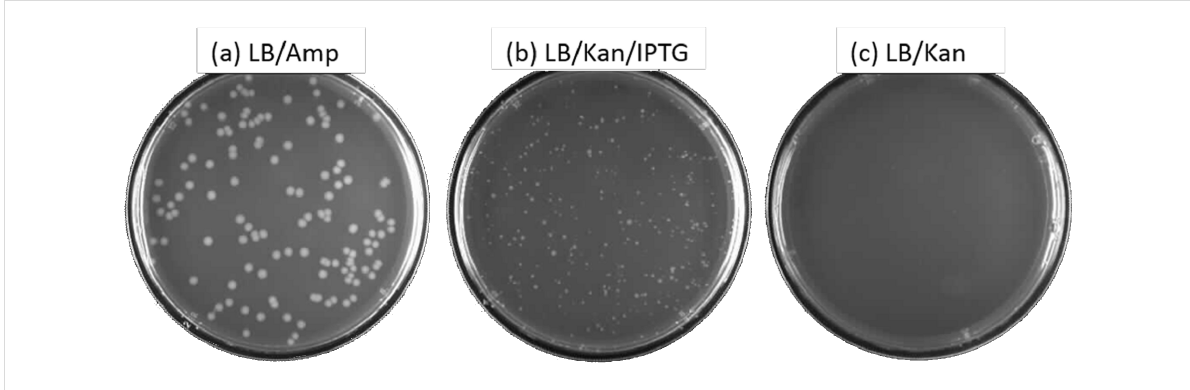
Figure 6: LB-agar plates spread, at various dilutions, with 25 µL cells transformed by plasmids containing the self-assembled kanamycin-resistance gene placed behind a β -galactosidase promoter in the TOPO expression vector (Invitrogen), but without selection for resistance to kanamycin. (a) The cell culture was diluted in two steps by a factor of 267,000. Then, aliquots (25 µL) were plated on agar containing only ampicillin. Replica plates (only one is shown) gave 123 and 99 colonies (average is 111 colonies), for a calculated 29.0 × 10 6 ampicillin-resistant colonies/mL in the original cell culture. (b) The cell culture was diluted by a factor of 2. Then, 25 µL was plated on agar containing IPTG and kanamycin. Replica plates (only one is shown) gave 308 and 276 colonies (average is 292 colonies), for a calculated 23,000 kanamycin-resistant colonies/mL in the original cell culture. (c) With insert but without IPTG induction of the gene for kanamycin resistance, no growth is seen.